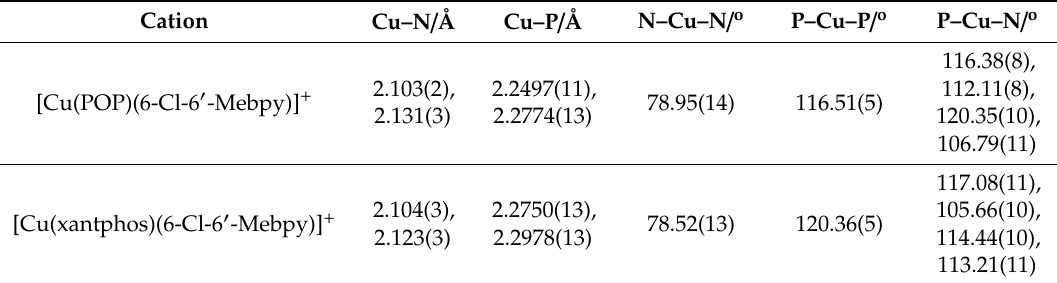
Table 1. Bond lengths and angles in the copper(I) coordination sphere in the cations in [Cu(POP)(6-